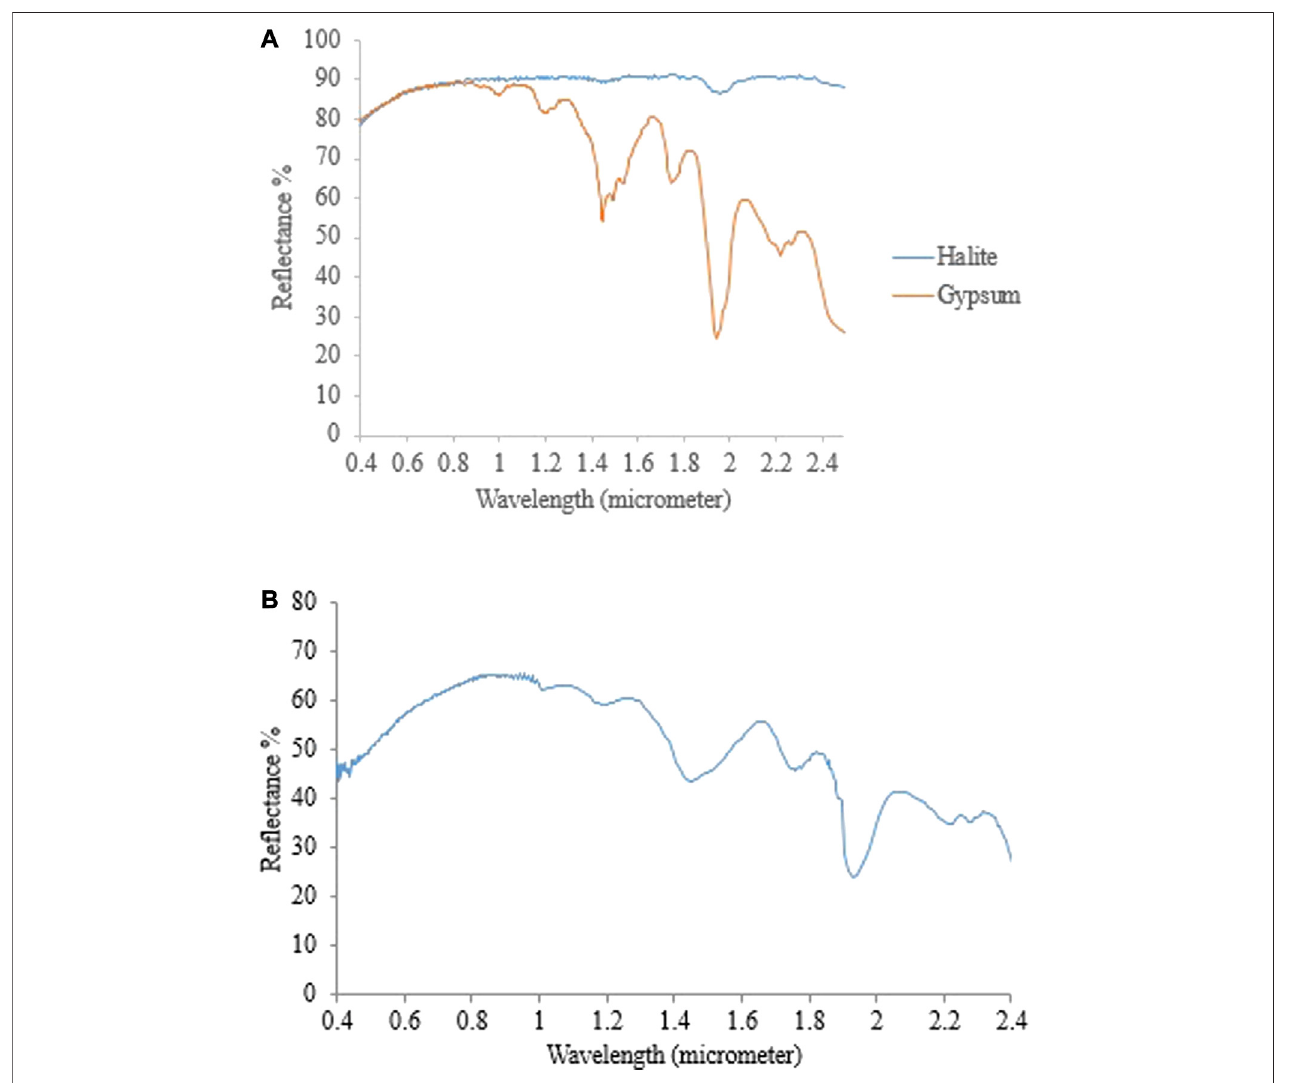
FIGURE 4 | The USGS laboratory spectra of gypsum and halite (A) (Clark et al., 1993) and GER 3700 radiometer spectrum of gypsum mixed with halite (B) .